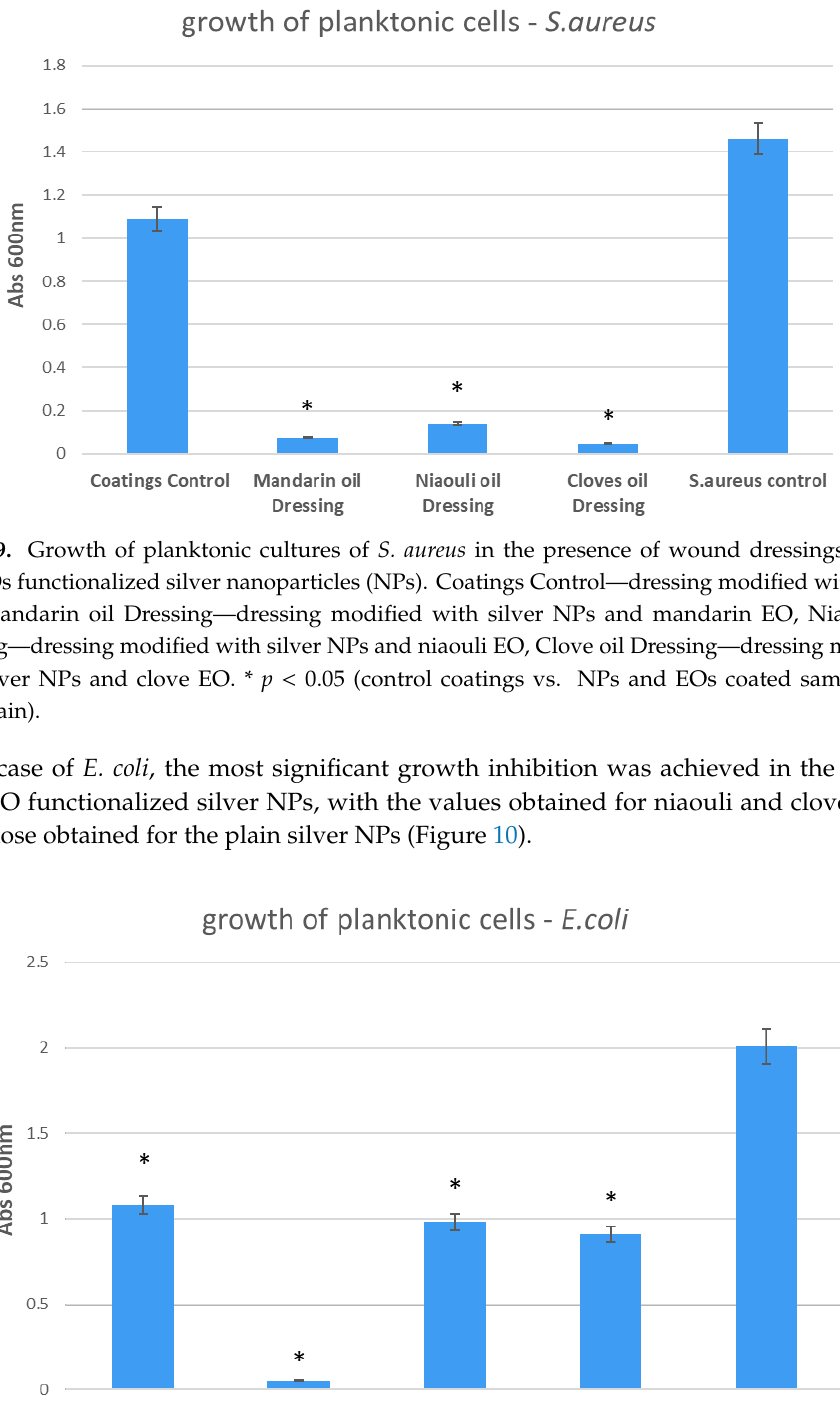
Figure 10. Growth of planktonic cultures of E. coli in the presence of wound dressings coated with EOs functionalized silver nanoparticles (NPs). Coatings Control—dressing modified with silver NPs, Mandarin oil Dressing—dressing modified with silver NPs and mandarin EO, Niaouli oil Dressing—dressing modified with silver NPs and niaouli EO, Clove oil Dressing—dressing modified with silver NPs and clove EO. * p < 0.05 (control coatings vs. NPs and EOs coated samples for each